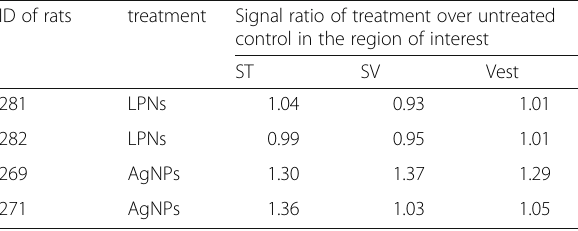
Table 1 Signal ratio of the inner ear region of interest in gadolinium-enhanced MRI ID of rats